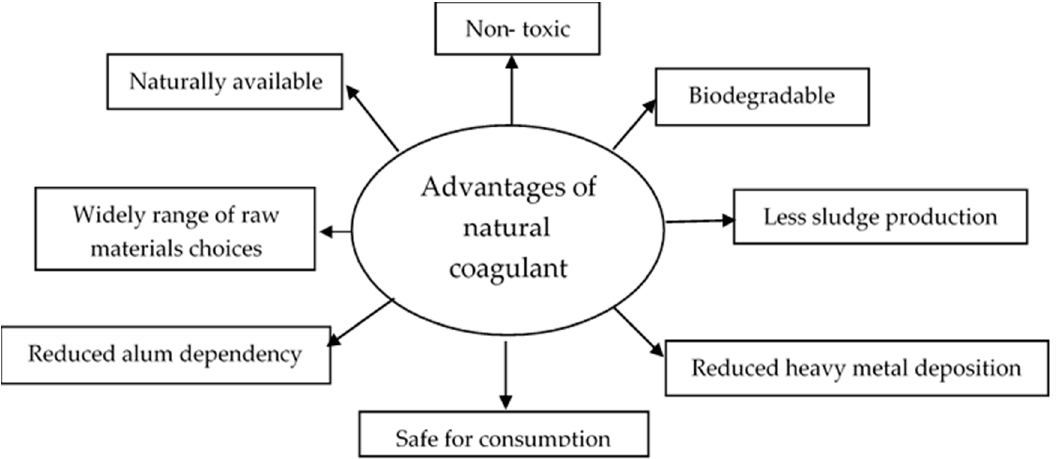
Figure 4. Advantages of utilising natural coagulant in microalgae harvesting.